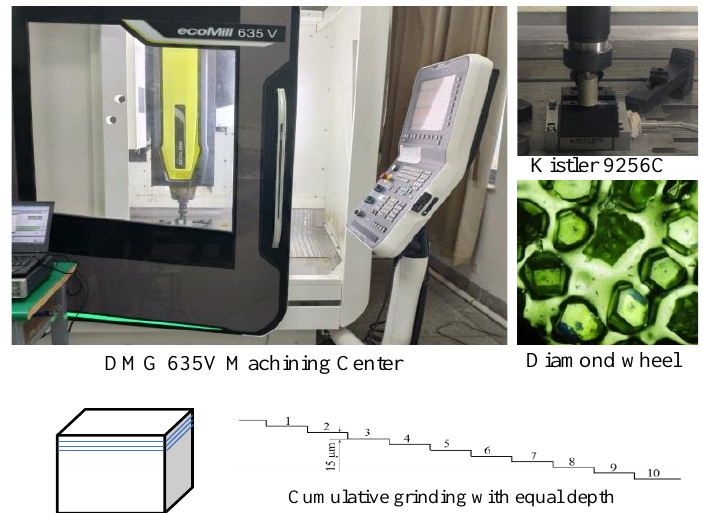
Figure 2. Experimental setup for grinding force monitoring.